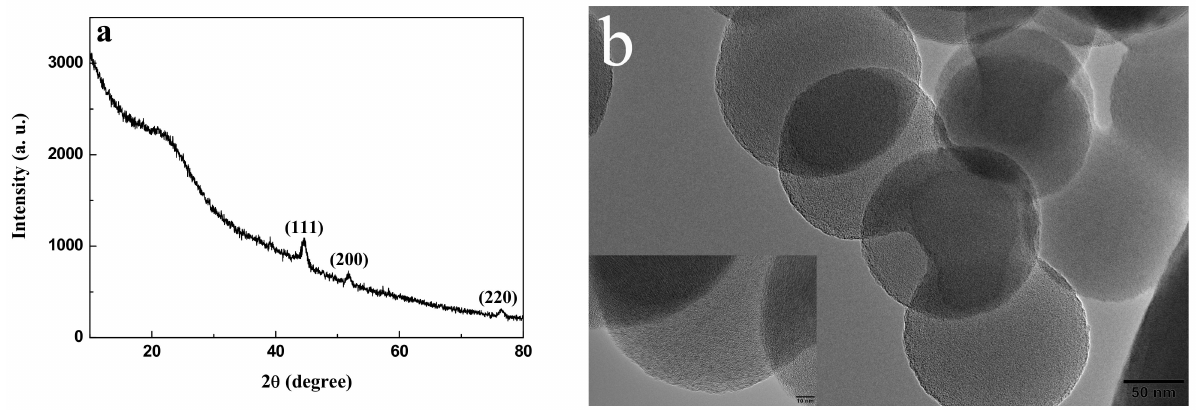
Figure 13. XRD pattern ( a ) and HTEM image ( b ) of the used carbon-supported metal nickel after 20 cycles. The inserted figure in ( b ) is a partially enlarged view of the